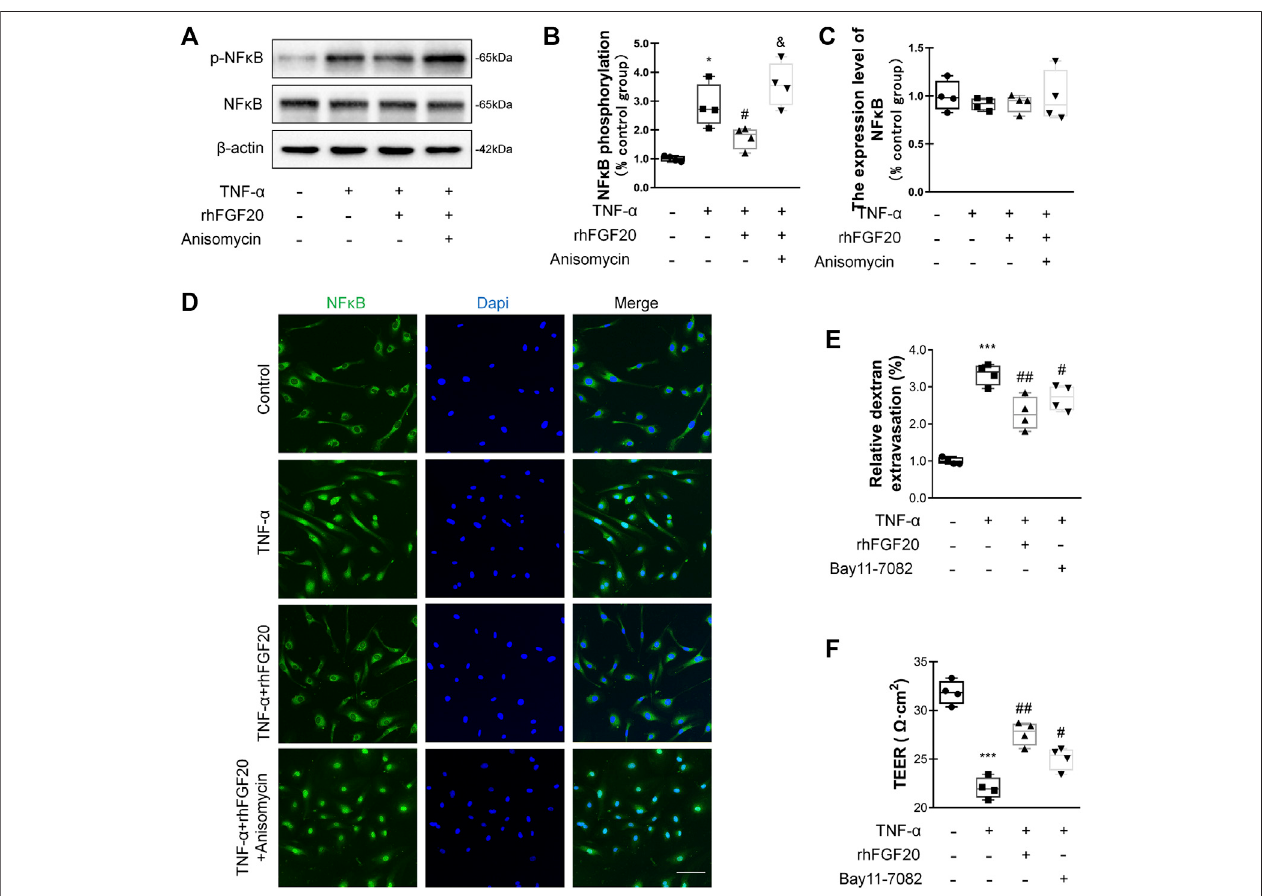
FIGURE 10 | rhFGF20 ameliorated HBMEC monolayer disruption by decreasing the in fl ammatory response via the JNK/NF κ B signaling pathway (A) Effects of rhFGF20andanisomycinon p -NF κ BandNF κ Blevels,asshownbywesternblotanalysisofthetotalcellularprotein,with β -actinusedastheloadingcontrolandforband density normalization (B – C) Effects ofrhFGF20 andanisomycinon p -NF κ BandNF κ Bprotein levels, asanalyzed byquanti fi cation ofwesternblotdata( n (cid:1) 4) (D) Effects of rhFGF20 and anisomycin on NF κ B activity. Nuclei are labeled with DAPI ( n (cid:1) 4) (E – F) The NF κ B inhibitor Bay 11 – 7082 also reversed TNF- α -induced increase in BBB permeability and decrease in endothelial resistance ( n (cid:1) 4). * p < 0.05, *** p < 0.001 vs. the control group. # p < 0.05, ## p < 0.01 vs. the TNF- α group. & p < 0.05, vs. TNF- α + rhFGF20 group. Data are presented as the mean values ± SD.